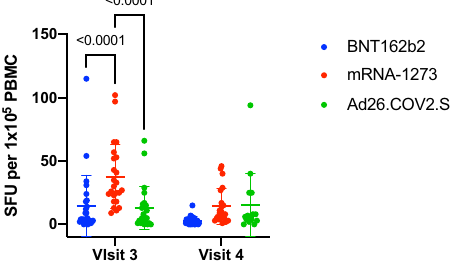
Fig. 3 SARS-CoV-2 spike protein-speci fi c T cell responses amongst vaccine recipients. PBMCs from the visit 3 and 4 timepoints were tested by an IFN- γ ELISPOT assay. Data are shown as spot forming units (SFU) per 100,000 PBMCs. Each data point is shown, the mean and standard deviation are plotted. Statistically signi fi cant differ- ences using a mixed effects model with the Geisser-Greenhouse correction for unequal variance and Holm-Sidak multiple compar- ison test are noted by the respective p